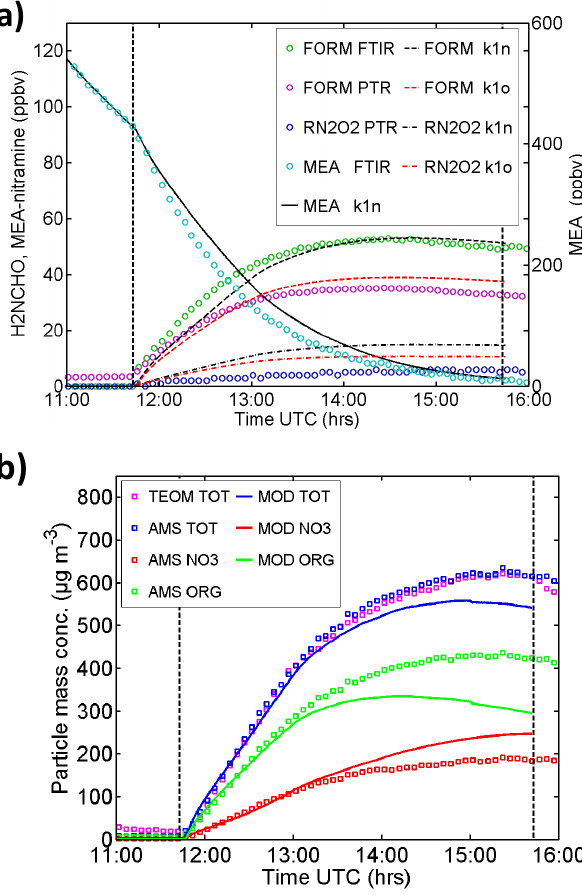
Fig. 5. Concentration time series of experiment E3 on 27 July 2010: (a) measured gas phase concentrations of MEA (FT-IR), for- mamide (FT-IR and PTR-TOF-MS)), 2-nitroamino ethanol (PTR- Fig. 4. Results of the fit for X 0 (horizontal axis) and Y 0 (vertical TOF-MS), and modelled concentrations of formamide (FORM) and axis) according to Eq. (11) for (a) experiment E1 and (b) experiment 2-nitroamino ethanol (RN2O2) using the k (OH+MEA) value from E2. The experiment period used in the relative rate determination EPI Suite v4.0 (red lines, “k1o”) and the value derived in this work was 1300s as indicated by horizontal yellow bars in Fig. 3. The (black lines, “k1n”), (b) measured and modelled mass concentra- result from the least-squares fit (LSQ) is indicated by the straight red tions of nitrate (NO 3 ), high-molecular weight organics > m/z 65 line. Fit parameters for E1 are a = − 0 . 04 ± 0 . 01, b = 1 . 86 ± 0 . 08, (ORG), and total (TOT) particles. Measured total particle mass χ 2 = 13 . 28 and for E2 are a =− 0 . 03 ± 0 . 02, b = 1 . 65 ± 0 . 07, χ 2 = data from AMS (blue squares) and TEOM (magenta squares) are in 6 . 57. The grey dashed line represents the 1:1 line. The error bars agreement. For better visibility, modelled nitramine concentrations indicate 1- σ statistical errors of both X 0 and Y 0 and these errors were scaled by a factor of 5 and measured nitramine concentrations include measurement errors of TMB (for X 0 ) and MEA (for Y 0 ) were scaled by a factor of 100. Vertical dashed lines indicate begin- mixing ratios and estimated errors of loss rates L and D SF . ning and end of the sunlit 6